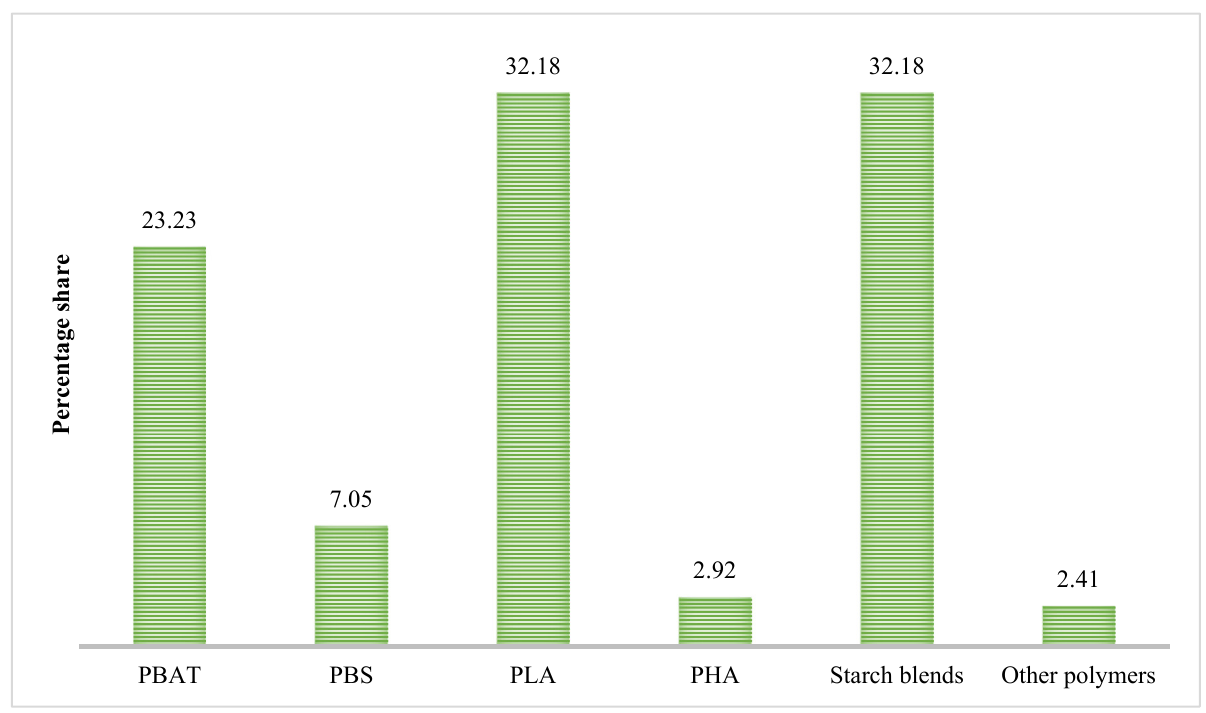
Figure 3. Global production share (%) of biodegradable polymers in 2020 [43].